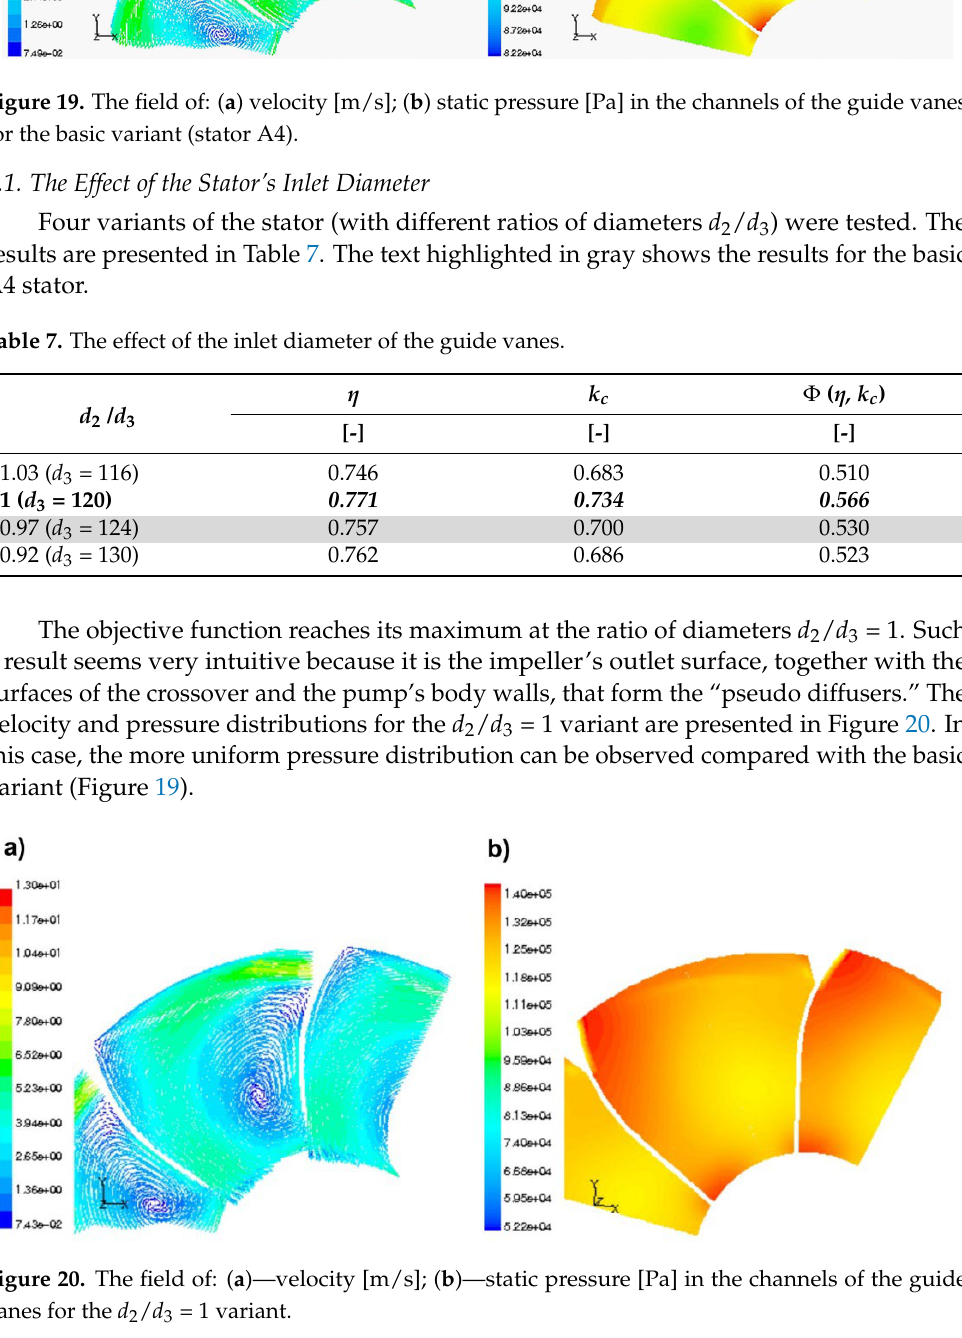
Table 8. The effect of the number of guide vanes.